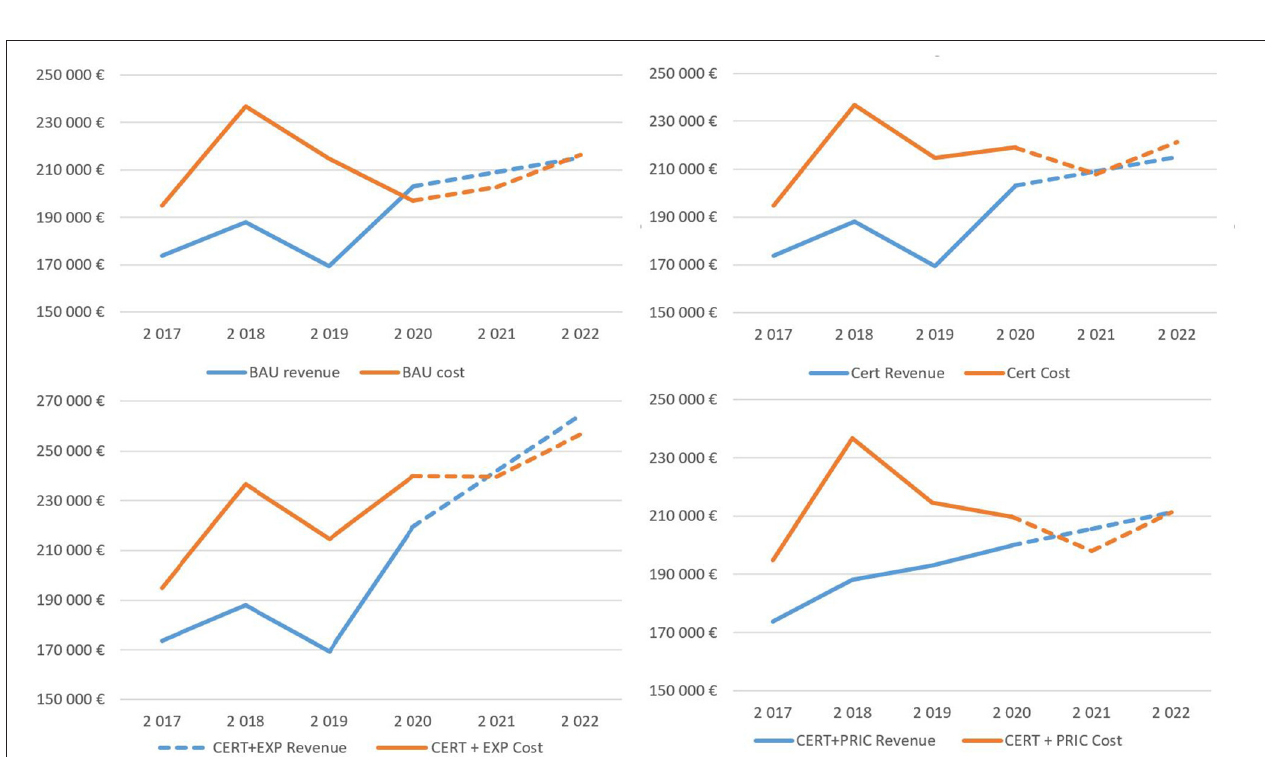
FIGURE 3 | Development of revenues and costs under the simulated